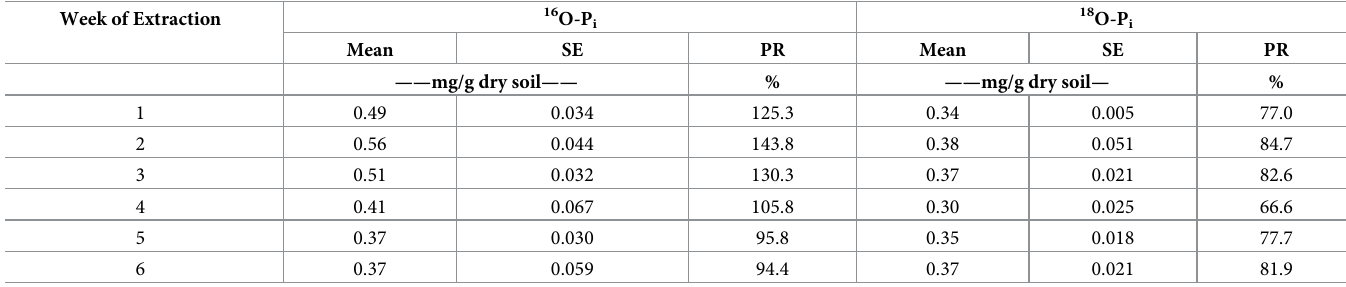
Table 3. Mean, standard error, and percent recovery of P i by